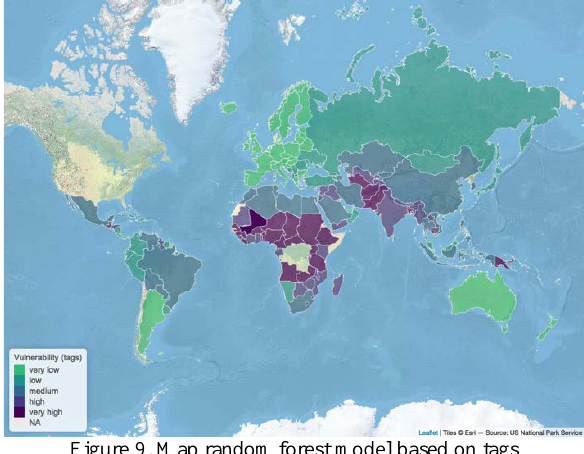
Figure 9. Map random forest model based on tags Compared to the World Risk Index 65% of the countries are in the same category.